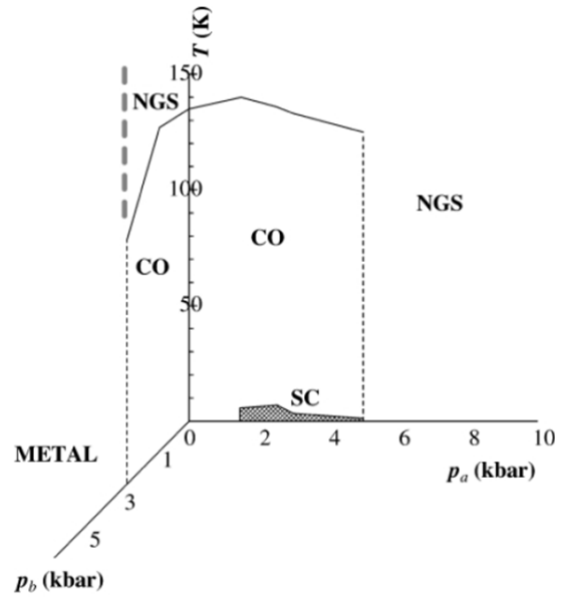
Figure 8. Temperature-Strain phase diagram of α -(BEDT-TTF) is seen only with the strain along the a -axis. Around the superconductivity, charge ordered phase is located. Reproduced with permission from